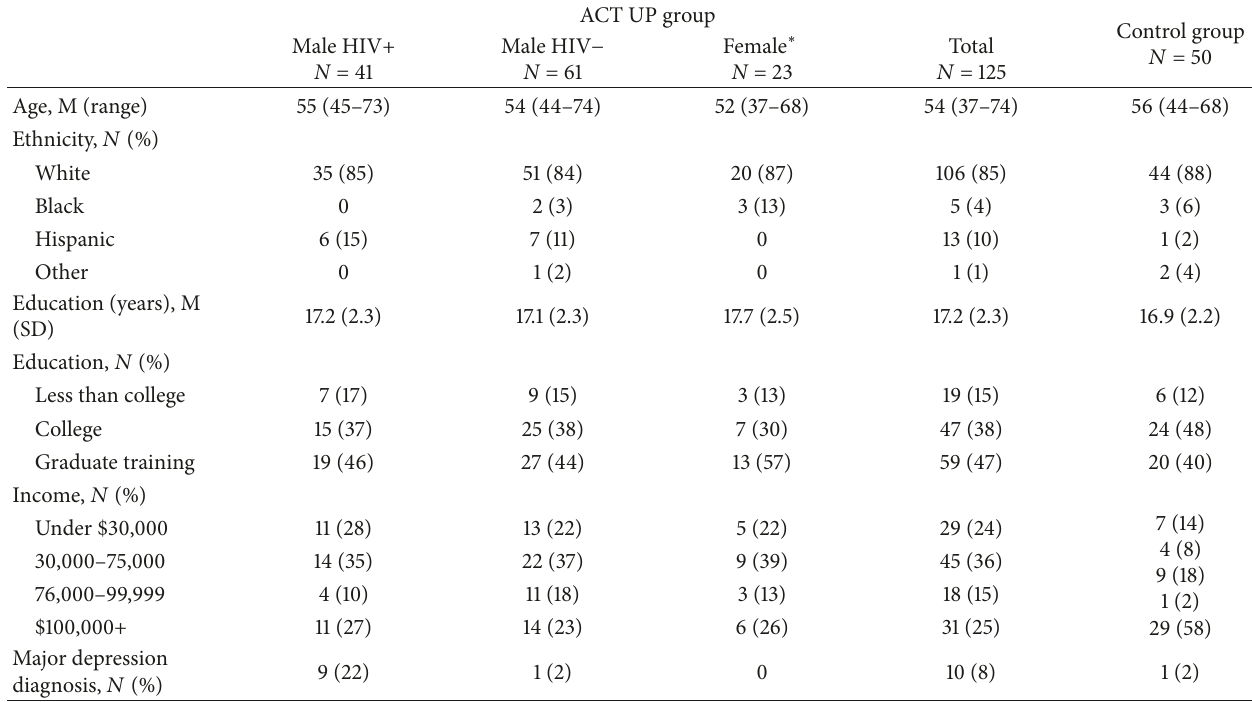
Table 2: Demographic characteristics of ACT UP group and control